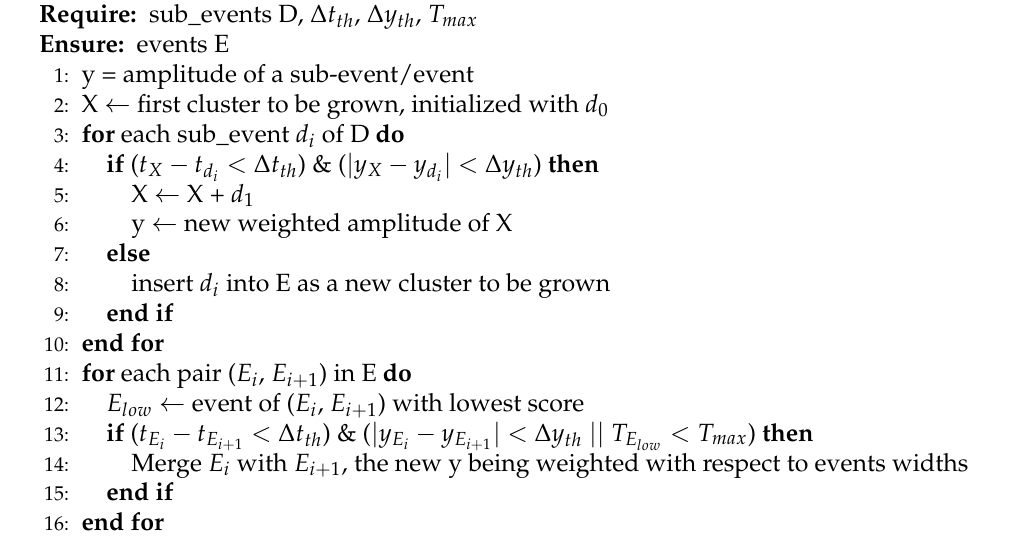
Algorithm 2 Sound events clustering